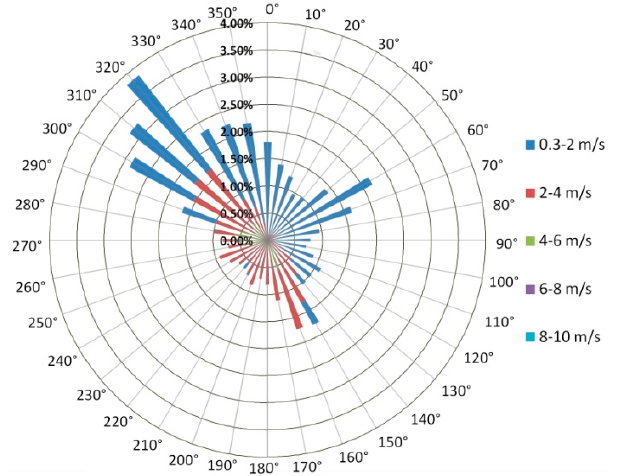
Figure 16. Wind direction frequency in Subang.